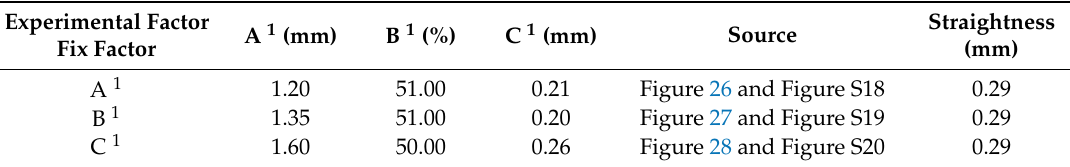
Table 7. Value of Experimental Factor for Straightness Y2.